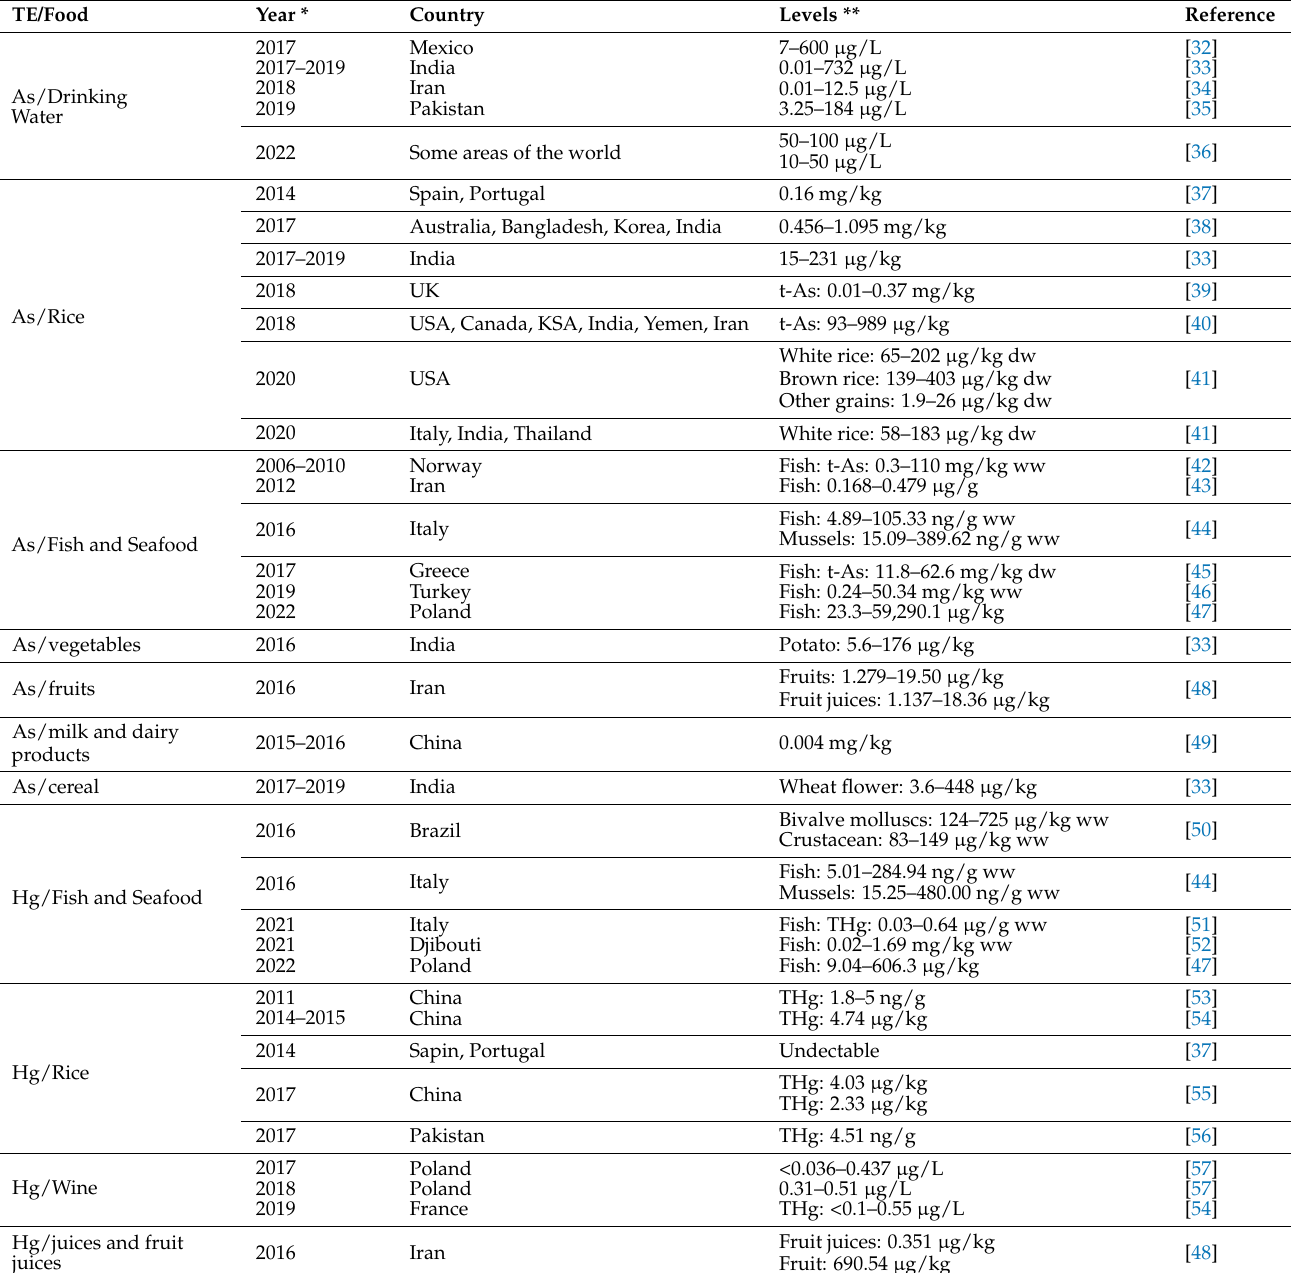
Table 1. Concentration ranges in some foods for As, Hg, Pb, Cd, and Cr in different countries of the